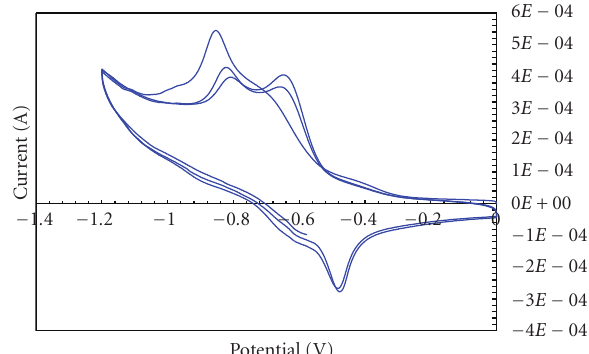
Figure 2: Cyclic Voltammogramm 0f 0.05M FeCl 3 . 6H 2 O/KOH (pH = 3), with scan rate 50 mV/s.